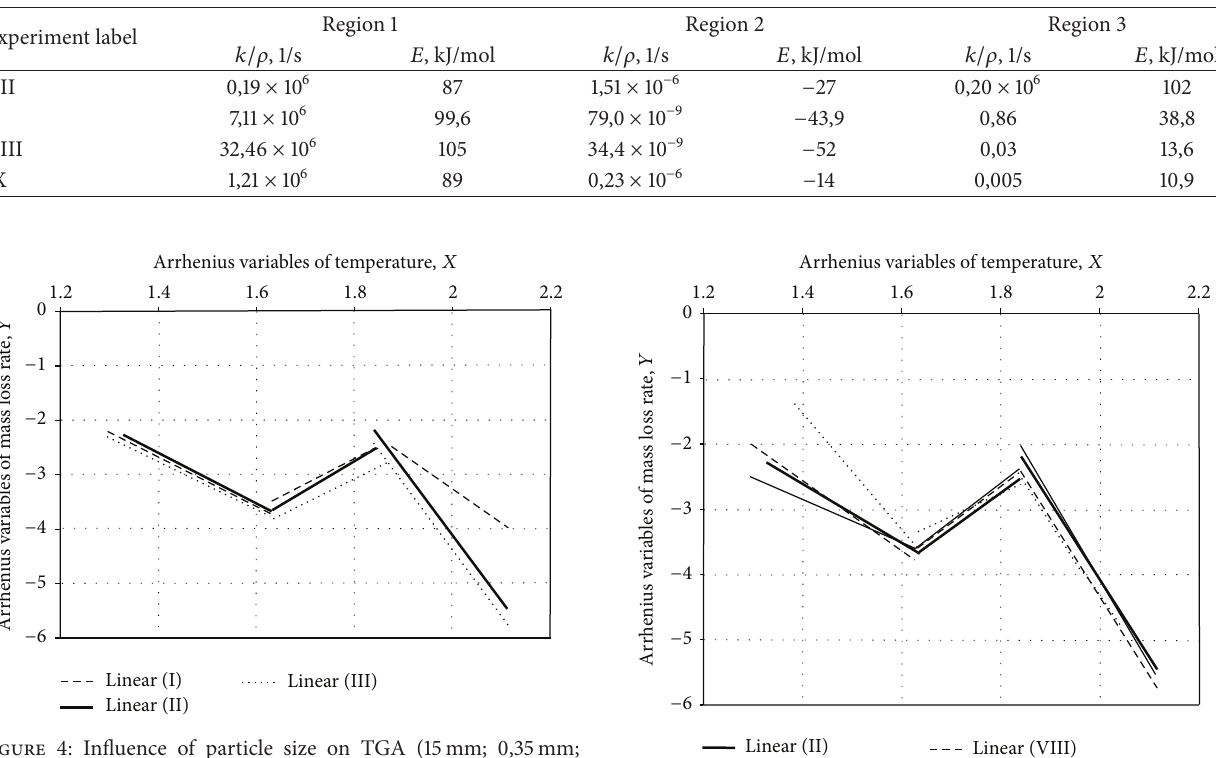
Figure 4: Influence of particle size on TGA (15mm; 0,35 mm; < 0,1mm).